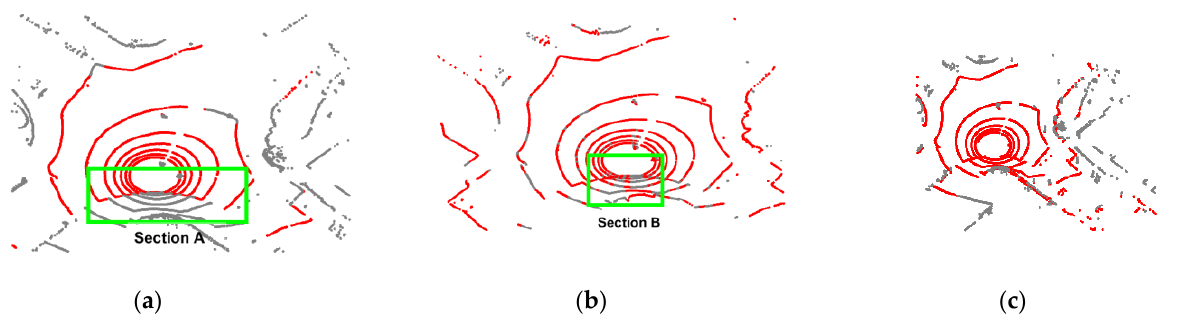
Figure 12. The segmentation effects of various algorithms in the case of intersection. ( a ) RANSAC algorithm. ( b ) RGF algorithm. ( c ) Proposed algorithm.